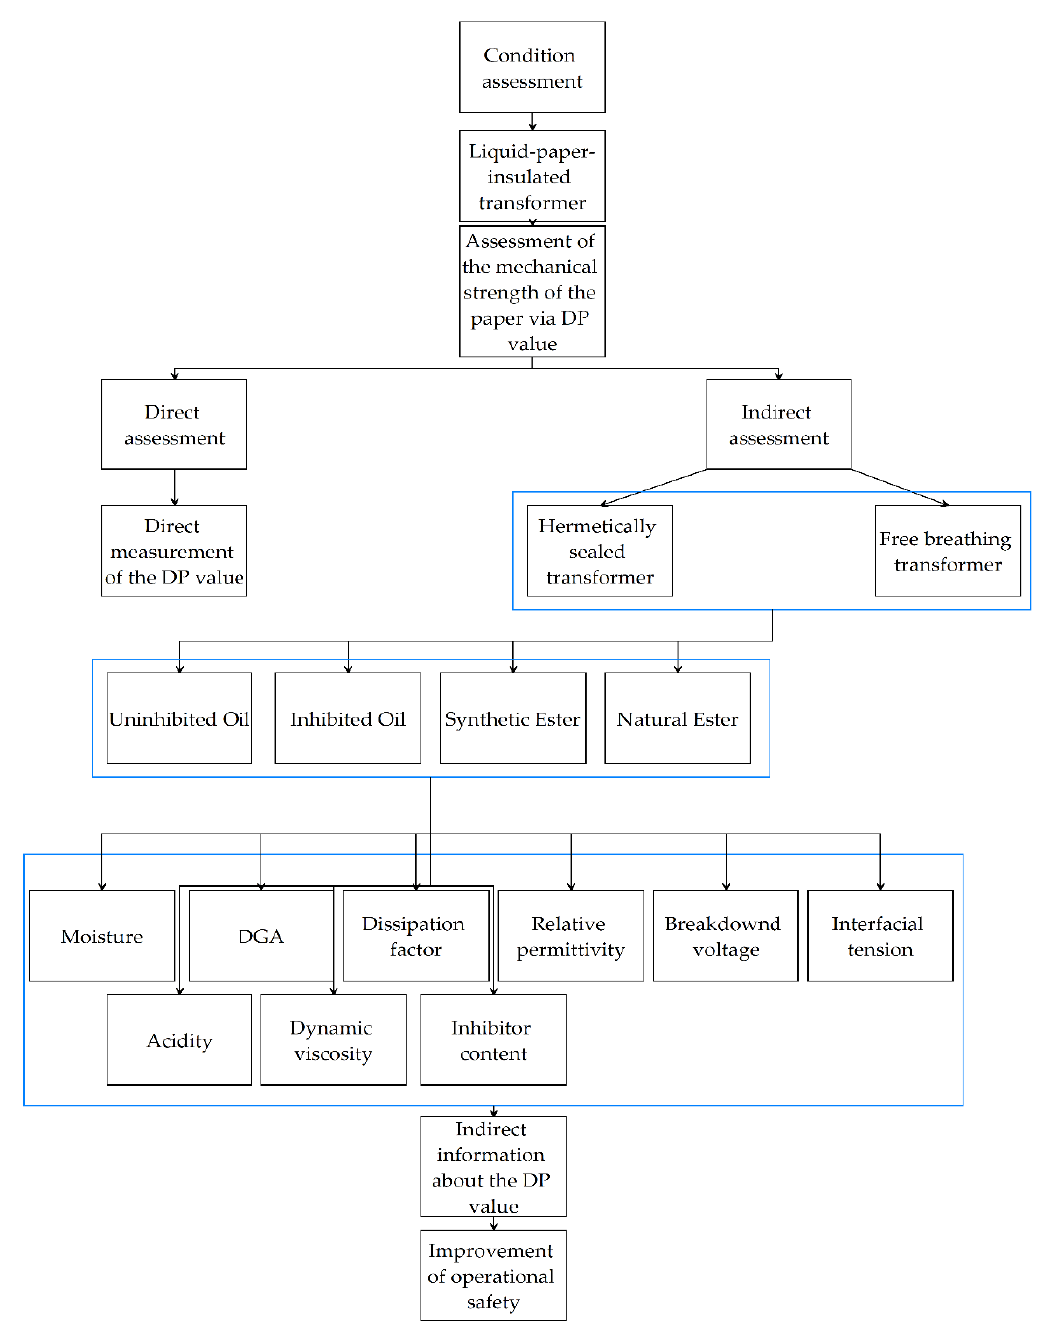
Figure 2. Block diagram illustrating the study as well as the intended condition assessment of the paper insulation.